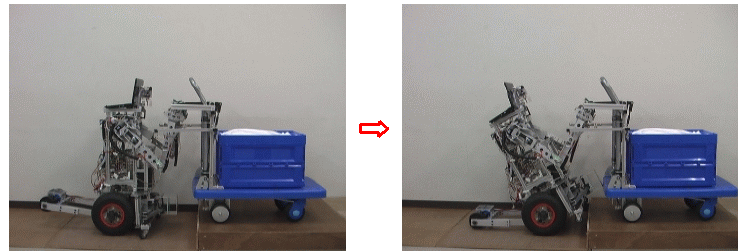
Figure 12. Stopper on the hand cart